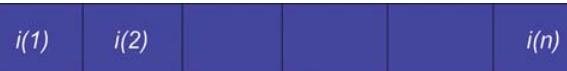
Figure 5. Landscape structure for model simulations. Movement is from neighbor to neighbor along a 1-dimensional linear array.